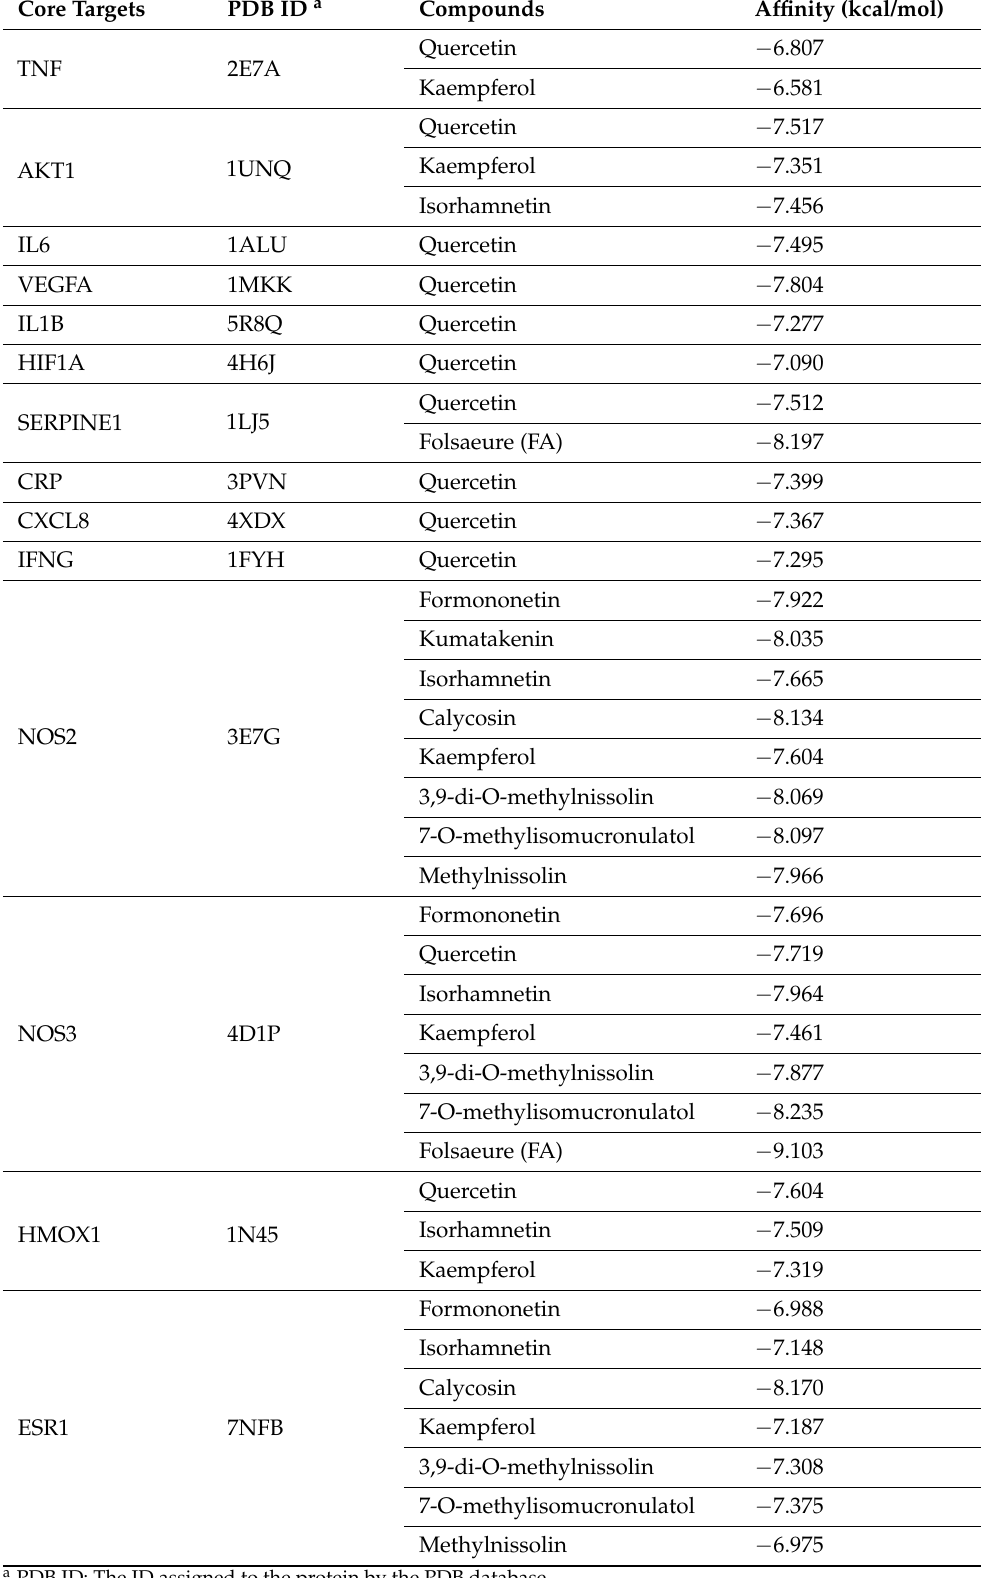
Table 5. The score of molecular